Question: Condense the content of this figure into a single sentence.
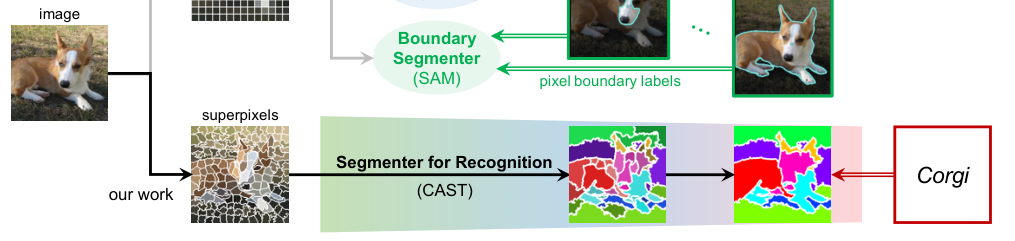
Answer: While prior work uses patches as visual units and treats segmentation and recognition as separate, supervised tasks with distinct models and data, our work uses superpixels as visual units and integrates hierarchical segmentation into the recognition process, learning it internally from a single recognition objective. Classifiers like ViT (Dosovitskiy et al., 2020) learn recognition from image-level labels. Semantic Segmenters such as Segmenter (Strudel et al., 2021) learn object segments from pixel-level class labels but lack part-whole granularity. Boundary Segmenters like SAM (Kirillov et al., 2023) learns regions of multiple granualities from boundary labels without hierarchical organization. In contrast, our Segmenter for Recognition (CAST) integrates a fine- to-coarse segment hierarchy directly into the recognition process. By graph-pooling over segment tokens, it effectively solves all three tasks concurrently within a visual parsing continuum.